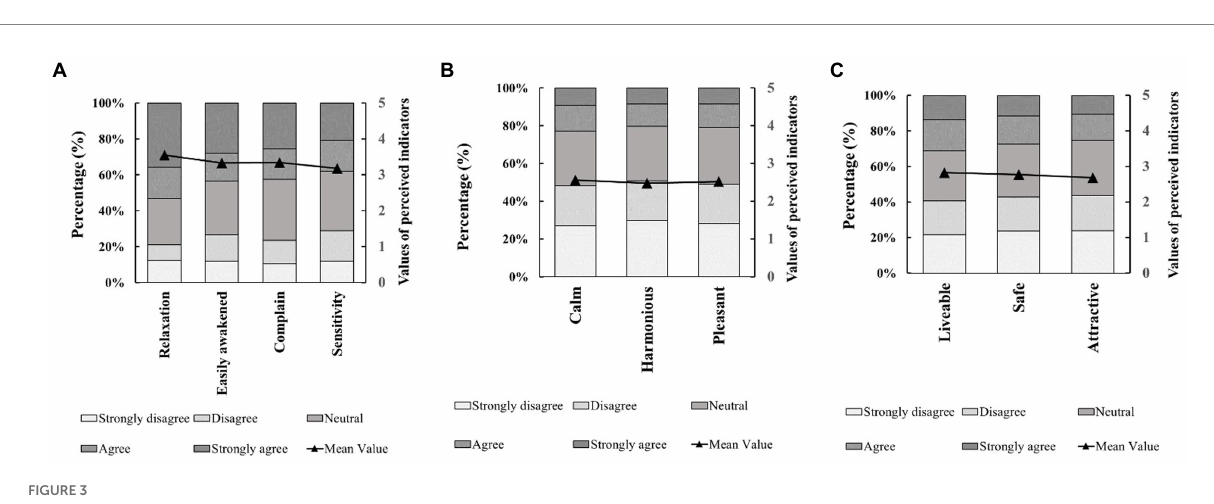
FIGURE 3 Rates of perceived indicators of noise-sensitivity (A) , sound-pleasantness (B) , and visual-liveability (C) .